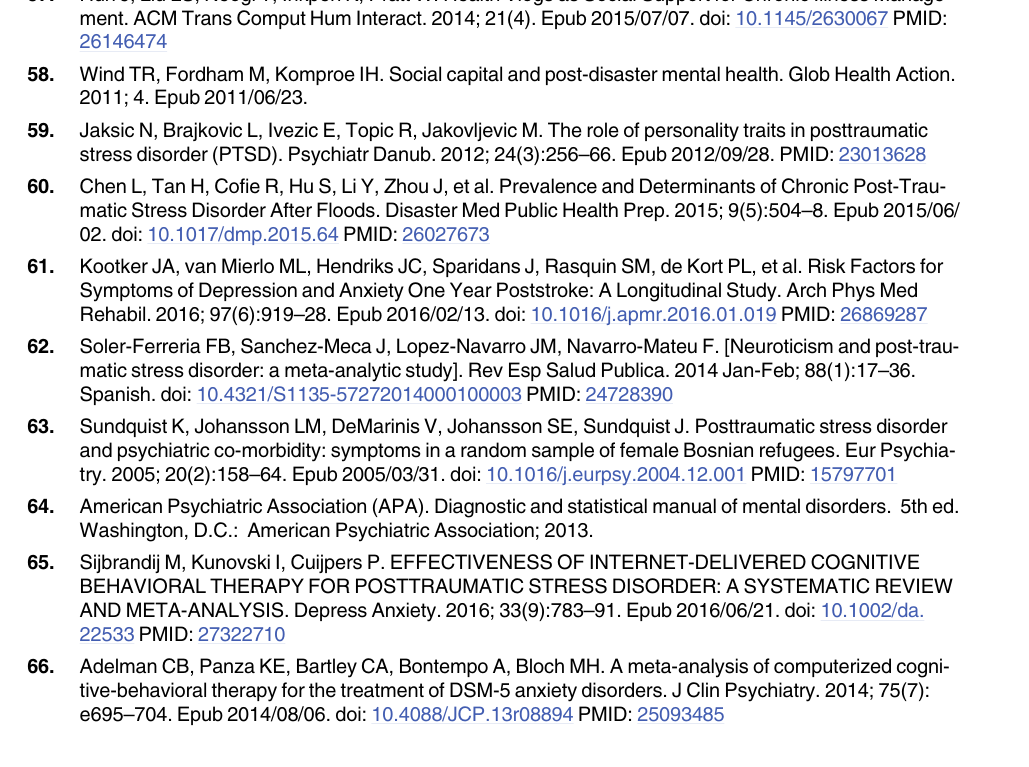
PLOS ONE | DOI:10.1371/journal.pone.0171557 February 7,